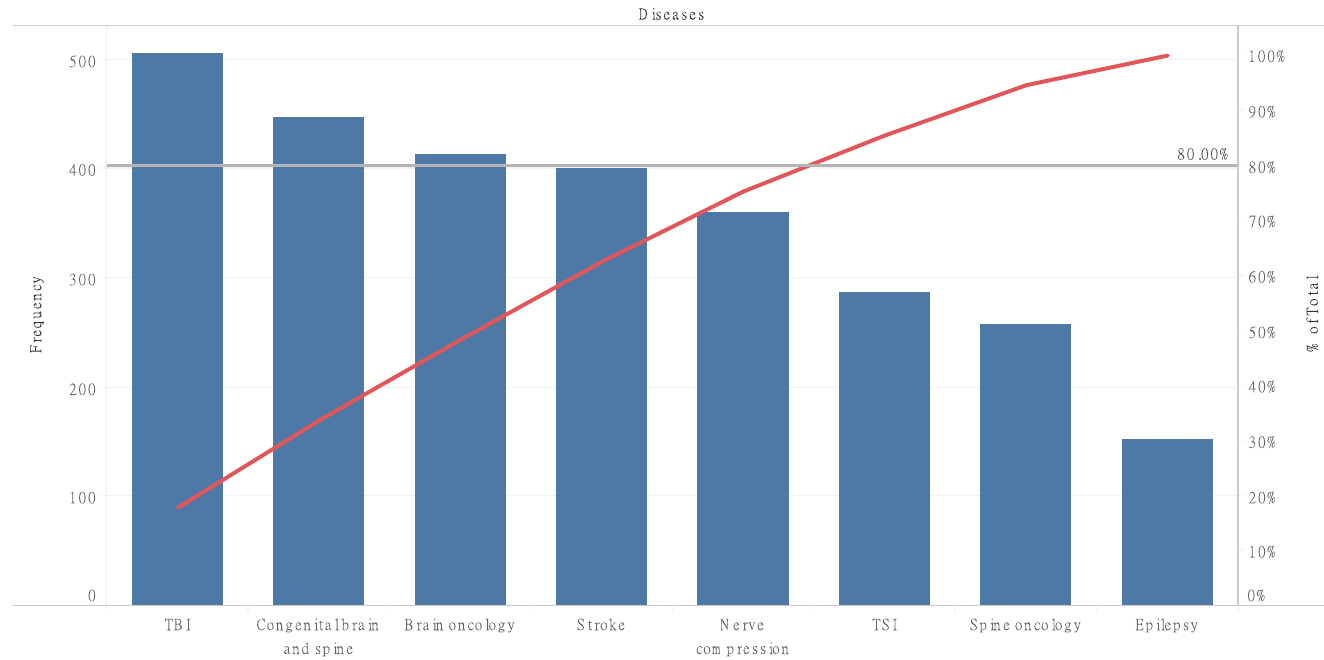
Fig 1. Pareto chart of diseases amenable to neurosurgery recognized by survey respondents. The black line shows the 80% cut-off while the red line shows the cumulative percentage total.